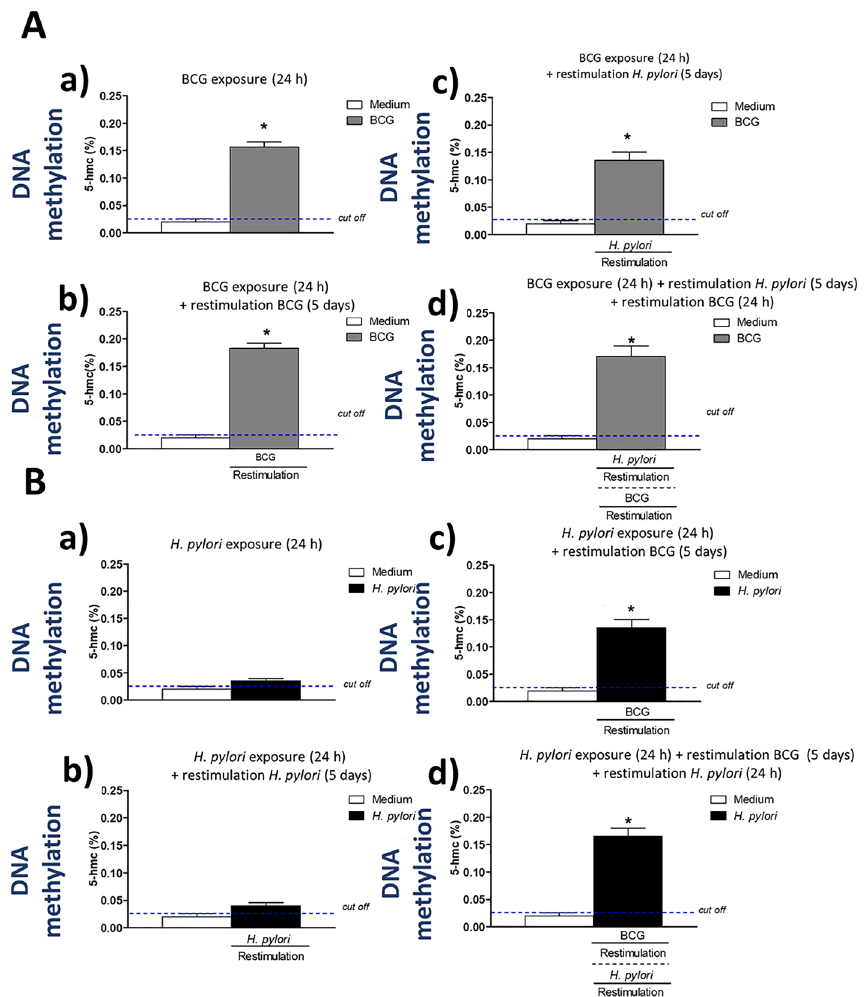
Figure 6. Global DNA methylation. Cells were primed with M. bovis BCG or H. pylori and then underwent restimulation with homologous or heterologous microbial agent. THP-1 macrophages primed with M. bovis BCG ( A ): cells primed for 24 h with M. bovis BCG (a); cells primed for 24 h with M. bovis BCG and restimulated for 5 days with M. bovis BCG (b); cells primed for 24 h with M. bovis BCG and restimulated for 5 days with H. pylori (c); cells primed for 24 h with M. bovis BCG then restimulated for 5 days with H. pylori and for an additional 24 h with M. bovis BCG (d). THP-1 macrophages primed with H. pylori ( B ): cells primed for 24 h with H. pylori (a); cells primed for 24 h with H. pylori and restimulated for 5 days with H. pylori (b); cells primed for 24 h with H. pylori and restimulated for 5 days with M. bovis BCG (c); cells primed for 24 h with H. pylori , restimulated for 5 days with M. bovis BCG and an additional 24 h with H. pylori (d). The global DNA methylation was determined by the ELISA with high DNA affinity strip wells, and capture as well as detection antibodies specific for 5 hmC were used. The quantity of hydroxymethylated DNA fragments was detected colorimetrically at OD = 450 nm. The percentage of 5hmC in DNA samples was calculated in reference to standard curve. Results are presented as median ratio ± range of three independent experiments. The difference statistically significant when p < 0.05 in Mann–Whitney U test. *Cells stimulated versus unstimulated (according to the time of stimulation). BCG or H. pylori MOI